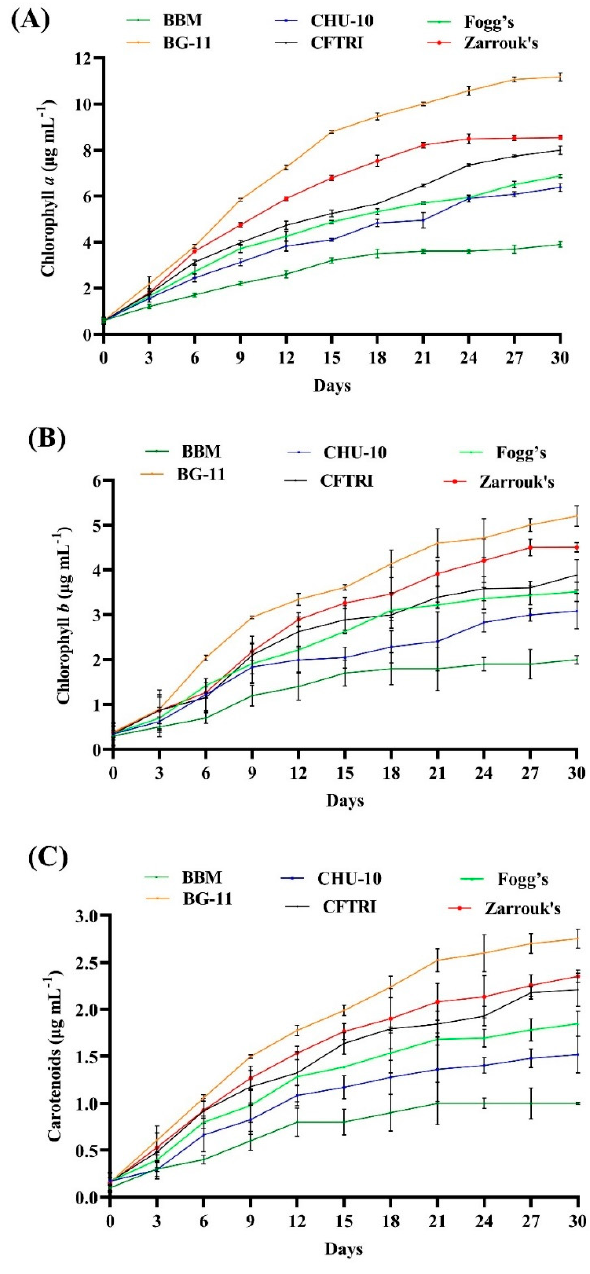
Figure 3. Effect of different growth media on the chlorophyll- a ( A ), chlorophyll- b ( B ) , and carotenoids ( C ) content of Scenedesmus rotundus -MG91048.